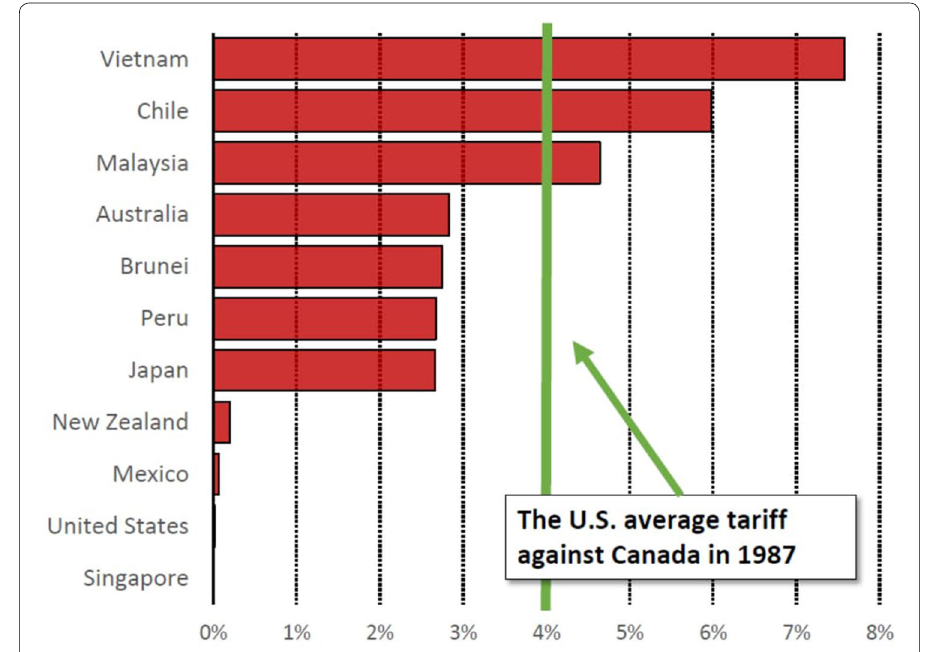
Fig. 1 Average tariff applied to Canadian exports